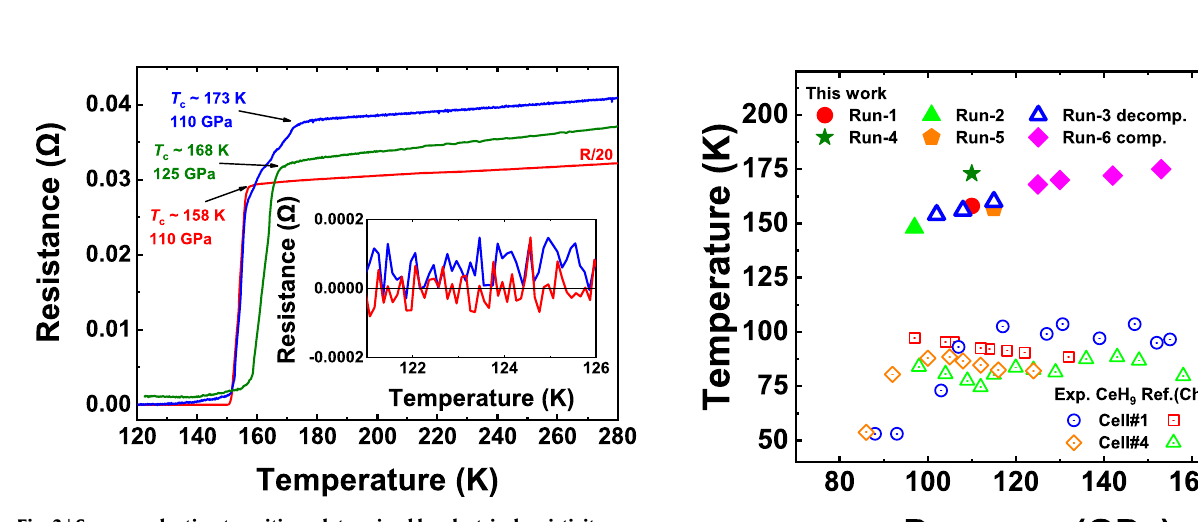
Fig. 3 | Superconducting transitions determined by electrical resistivity mea- surements in typical cells. Resistance measurements of synthesized (La,Ce)H 9 . Red curve: sample at 110GPa with T c ~158K. Green curve: sample at 125GPa with Fig. 4 | T c versus pressure for P 6 3 / mmc -(La,Ce)H 9 . The variation of super- T T conducting critical temperature T c with changing pressure; the results from six c ~168K. Blue curve: sample at 110GPa with c ~173K. The near-zero resistance is shown on a smaller scale in the inset. different experiments are marked in different colors. Comparison data on CeH 9 were taken from work by Chen et al. reported in ref.